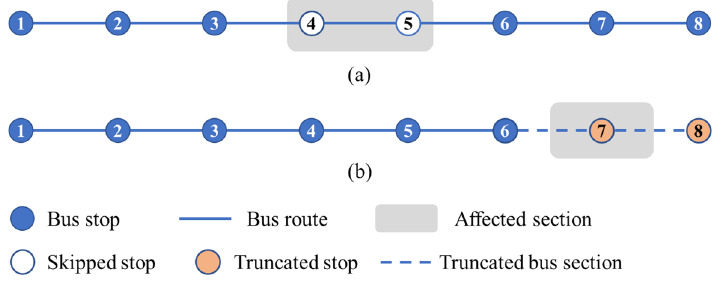
Figure 2. Illustration of the two strategies: ( a ) stop-skipping strategy and ( b ) truncation